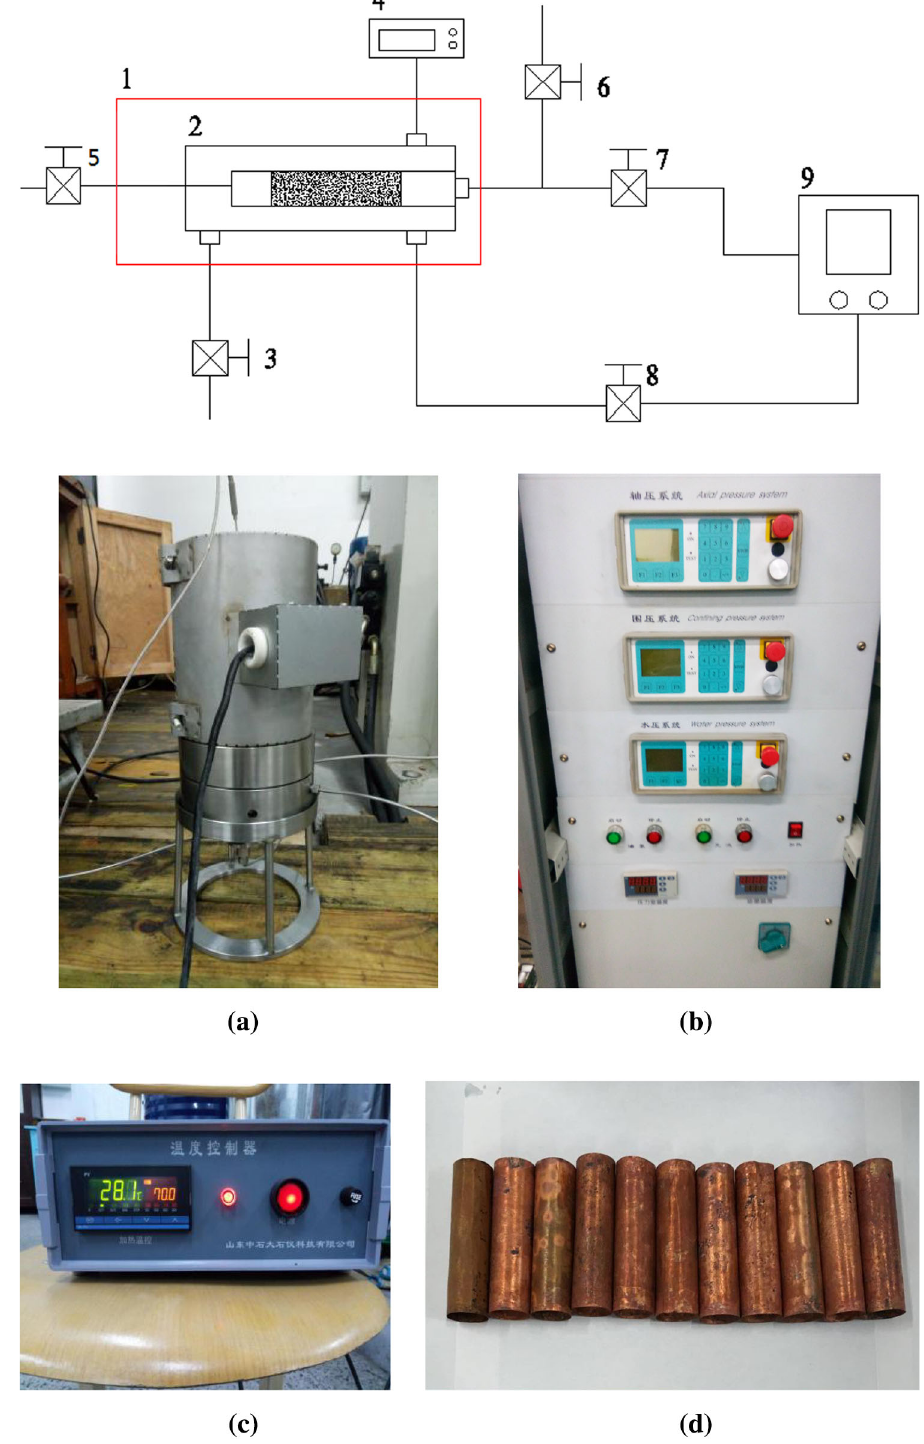
Fig. 1 Flowchart of the experimental device for rock compression coefficient ( 1 : heating device; 2 : core holder; 3 : vent valve for confining pressure; 4 : temperature controller; 5 : vent valve for pore pressure; 6 : vacuum cutoff valve; 7 : cutoff valve for pore pressure; 8 : cutoff valve for confining pressure; 9 : EDC servo control system)